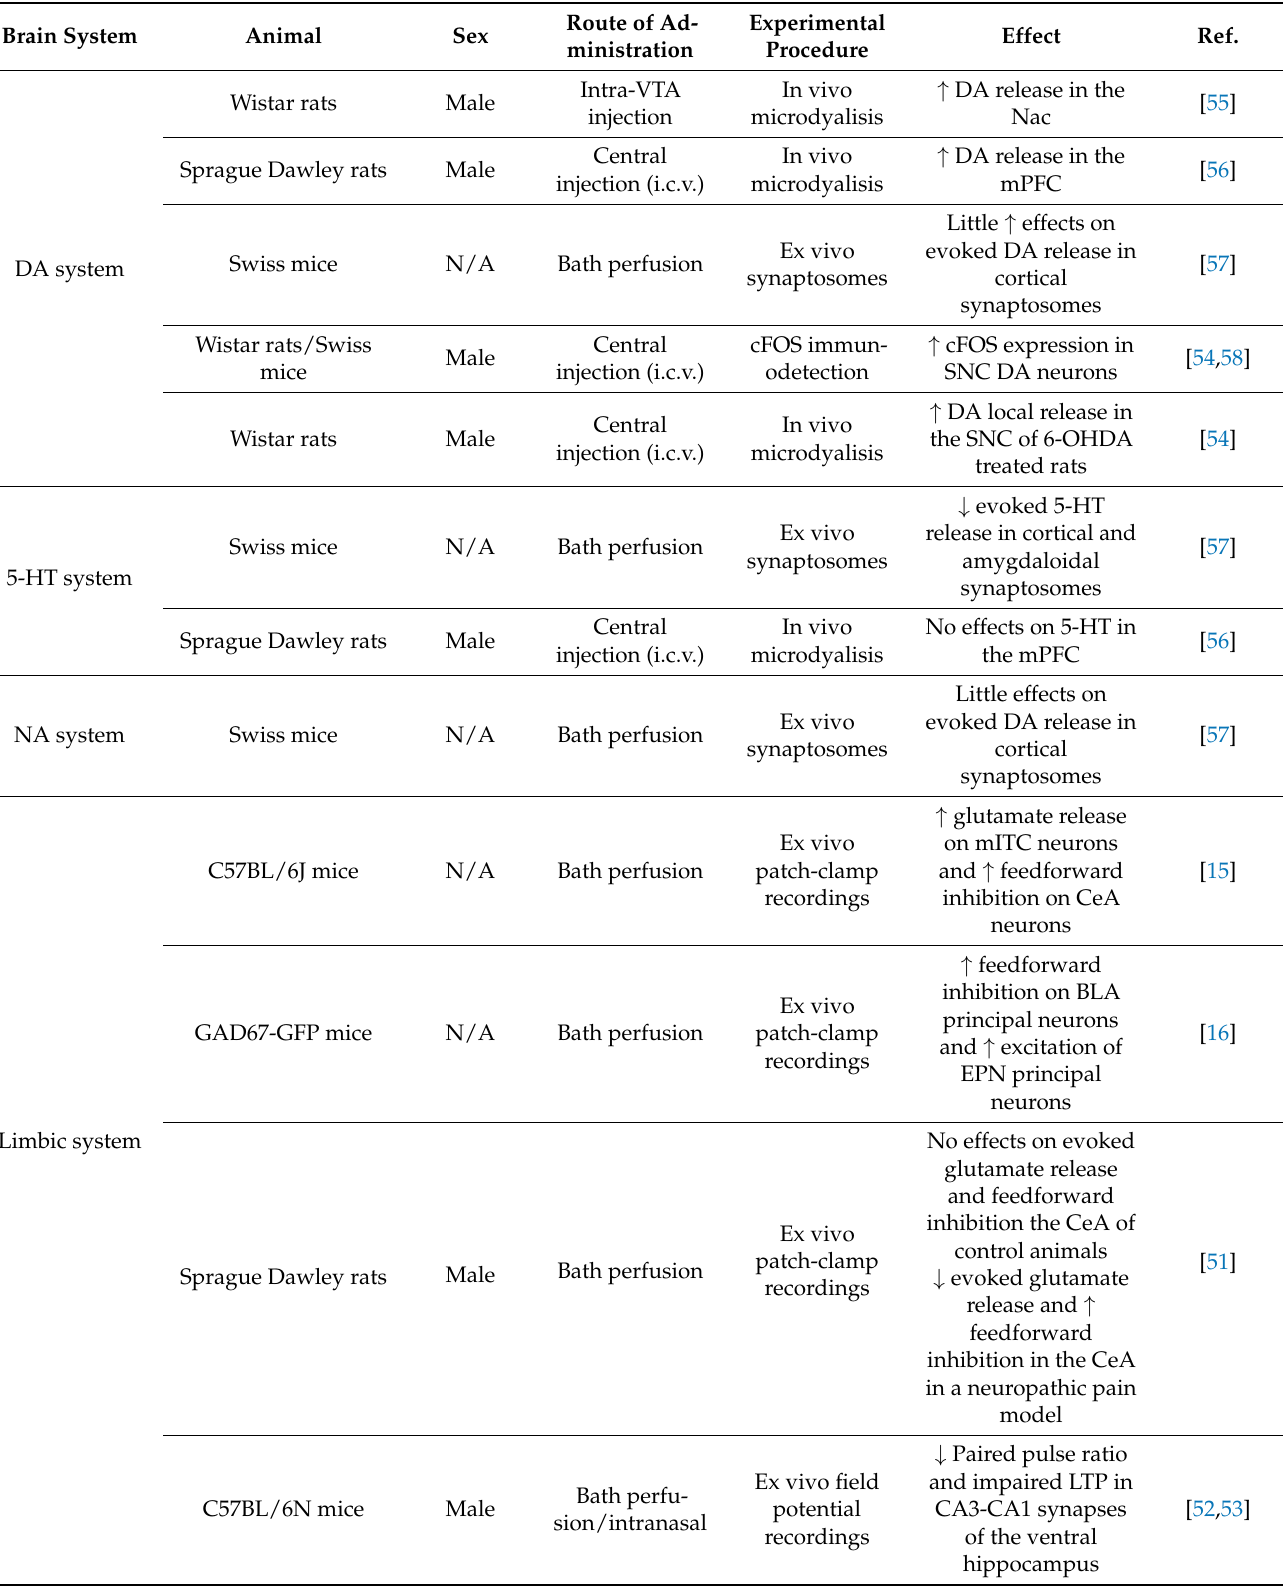
Table 1. Neurobiological effects of